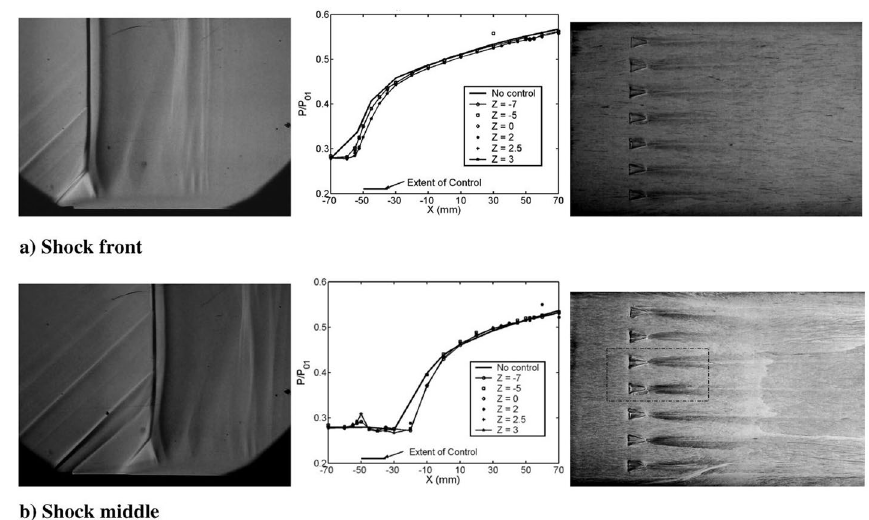
Fig. 14 Schlieren flow visualizations, wall pressure measurements, and surface oil-flow visualizations for Vane-type Sub-Boundary Layer Vortex Generator